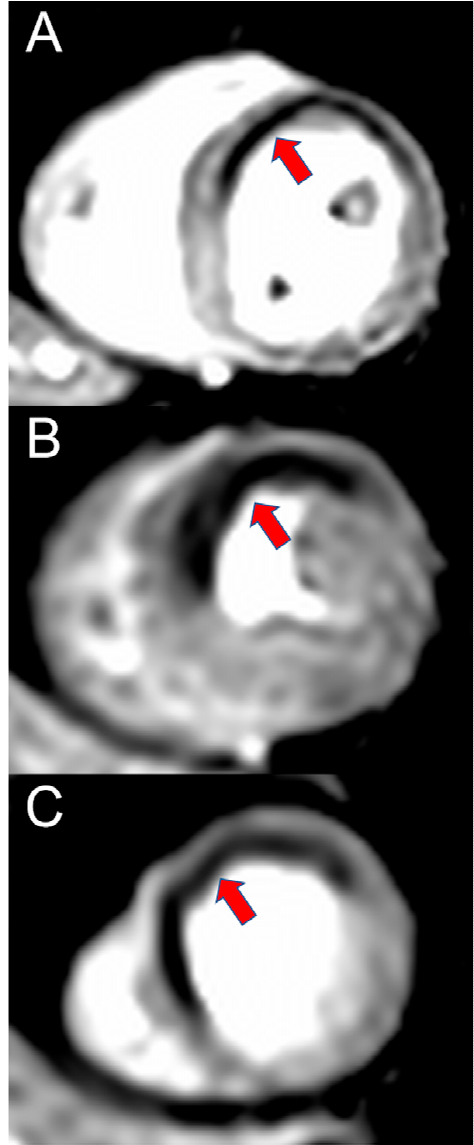
Figure 1. Imaging example of a stress CMR. A 58-year-old female patient with atypical angina symptoms and low pretest probability was referred for a stress CMR. The stress perfusion imaging revealed an extensive perfusion deficit (red arrows) of the anterior and anteroseptal wall on the basal ( A ), mid-ventricular ( B ) and apical ( C ) slice. An invasive coronary angiography showed a subtotal stenosis of the proximal left anterior descending artery (LAD) and the diagonal branch.